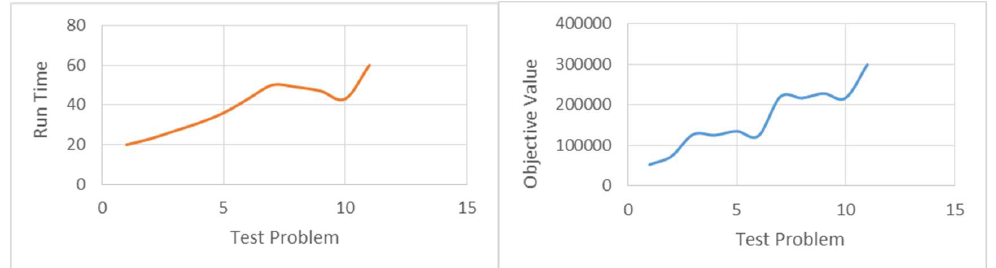
Fig. 16. Objective value and run time for scenario 7